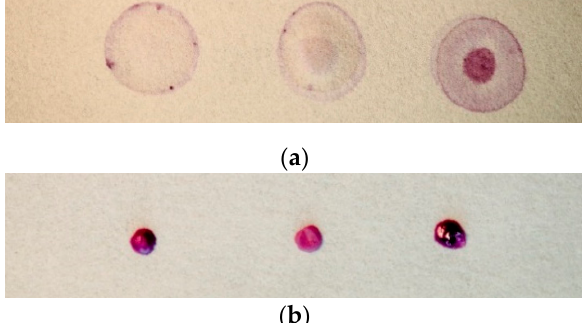
Figure 4. Comparison of Whatman papers. Fortified food matrices (from left to right, corn flour, 10 µ g / mL NaFeEDTA, Tanzanian wheat flour, 8.3 µ g / mL Fe type unknown, infant formula, 12 µ g / mL FeSO4). Whatman no.4 papers ( a ) resulted in heterogeneous and inconsistent output. Using the same procedure, Whatman 1PS papers ( b ) showed improved sensitivity and reliability with food